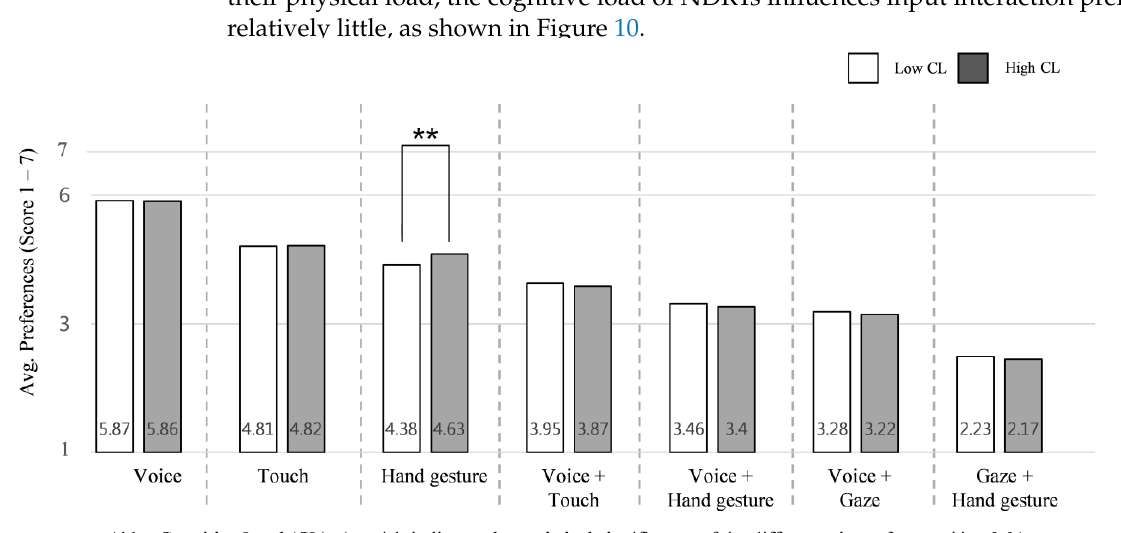
Figure 10. Average preference for the seven input interactions according to cognitive load of NDRTs: low cognitive load vs. high cognitive load.